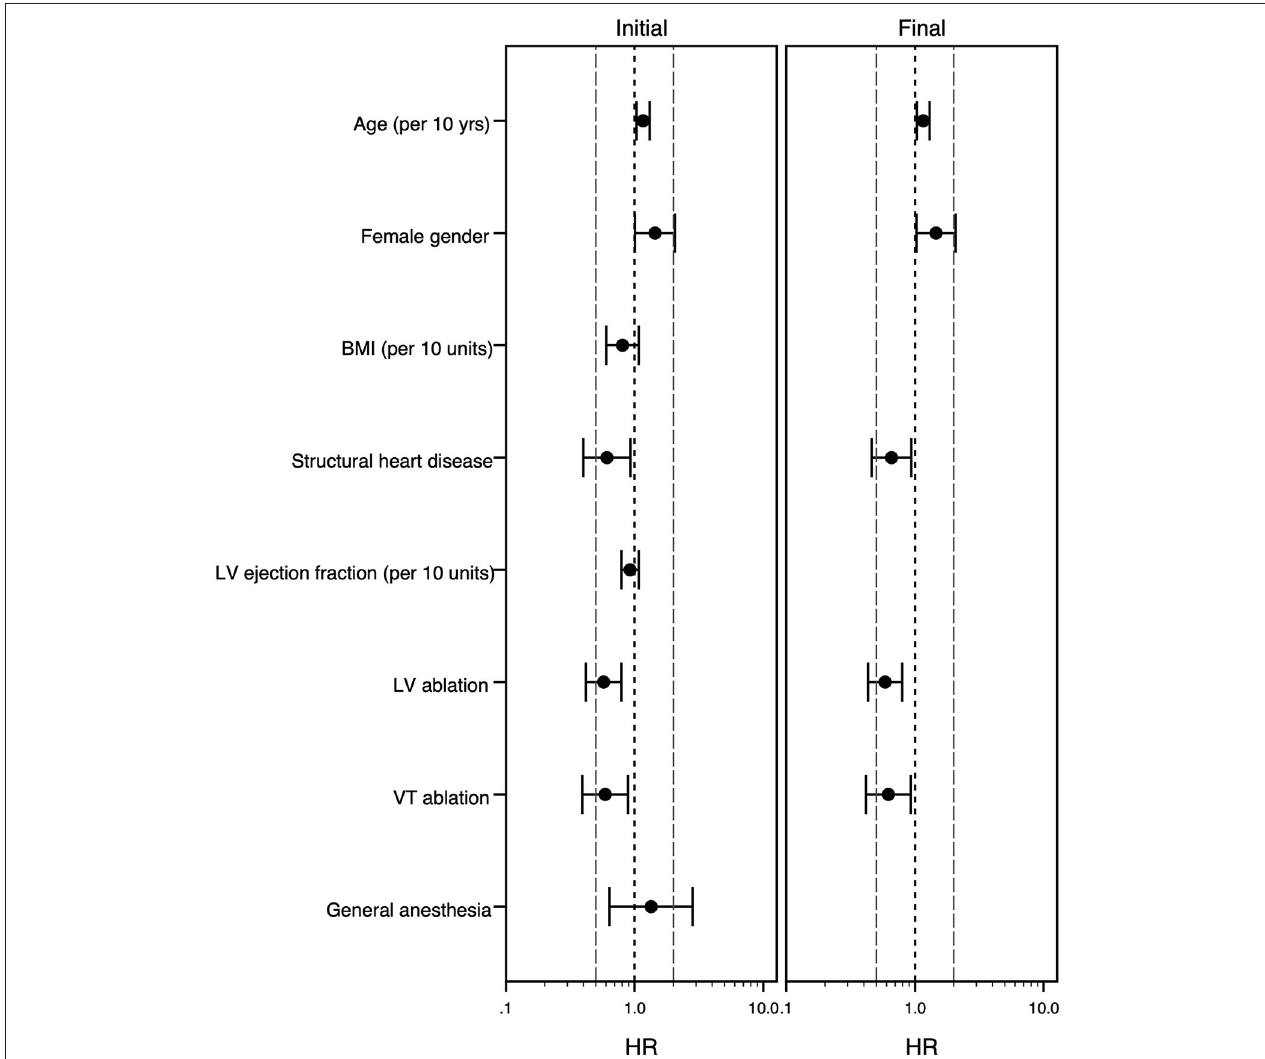
FIGURE 2 | Forest plot of the multivariable Cox model analyzing risk factors for longer procedure duration. The multivariable Cox-regression analysis is displayed. Hazard ratio < 1 stands for association with longer procedure duration, while hazard ratio > 1 goes along with shorter procedure duration. The initial model (left panel) and final model (right panel) is shown. The grouping variable “structural heart disease” was forced into the model equations, all other covariates were selected following the forward-stepwise variable selection method. For age, body mass index and left ventricular ejection fraction the effect of an increase of 10 years/kg/m 2 /% is shown. Hazard ratios (point) with 95% confidence intervals (whiskers) are displayed. BMI, body mass index (kg/m 2 ); HR, hazard ratio; LV, left ventricle; VT, ventricular tachycardia, yrs., years.